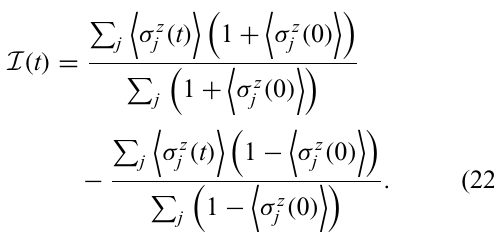
FIG. 5. Quantum simulation of the approximate Haldane- Shastry model using Floquet engineering. (a) We prepare an initial state i , apply the decoupled Floquet engineering sequence [Eq. (18)] that results in H ∼ H H − S , and measure in some basis f . (b) Creating a polarized state and measuring it in the same basis, a comparable slow decay of the average magnetization is seen for i along x , y , or z (dark to light). (c) Preparing a Nèel state experimentally, the dynamics measured along z (left) show com- plex oscillations and recurrences without thermalization. The average magnetization from (b) (dashed line) is provided as a guide to the eye indicating the approximate rate of depolarizing decoherence. (d) The numerics show behavior that is very similar to that of experiment up to the overall decoherence. The colored lines with markers (and the lower heat plot) are a numerical sim- ulation of the experimental Hamiltonian, while the black lines (dashed for odd ions, solid for even ions) are the ideal transla- tionally symmetric Haldane-Shastry chain with the same number of ions and the same average nearest-neighbor spin coupling. The experimental points are the average of 200 repetitions, with error bars of 1